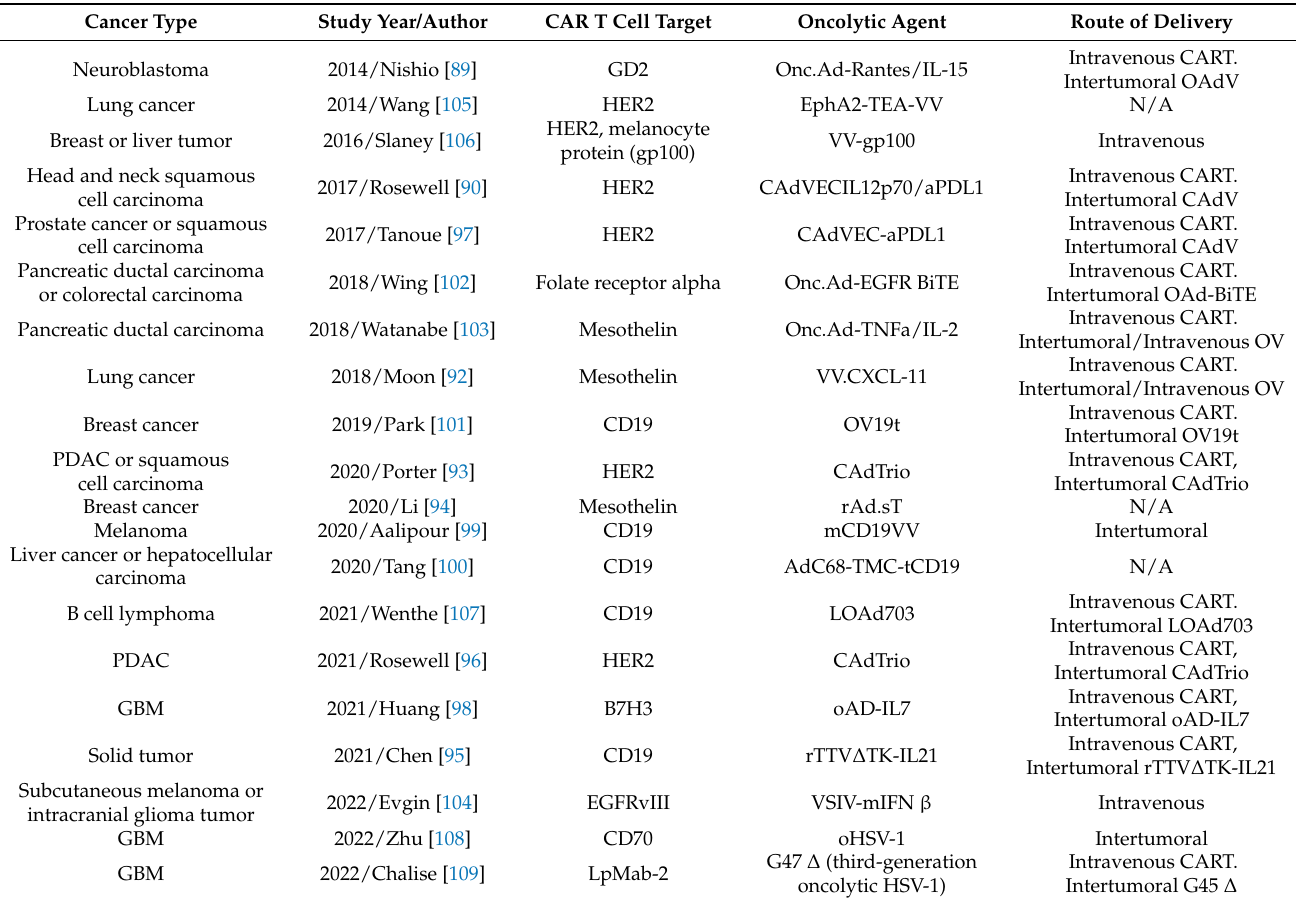
Table 3. Preclinical studies of combined CAR T cell therapy and oncolytic viral therapy in pediatric solid